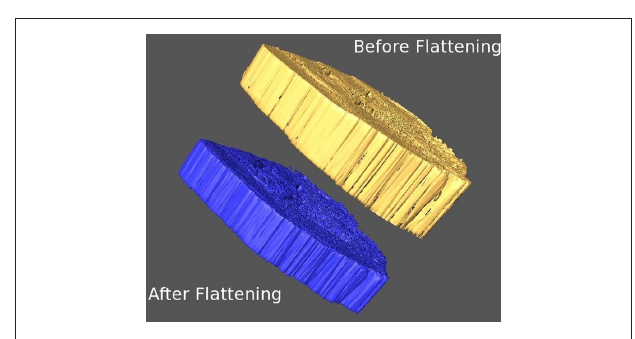
Figure 3 | Before and after flattening. Isosurfaces are plotted for an uncorrected digital section (yellow) and its corrected volume after the flattening (blue).